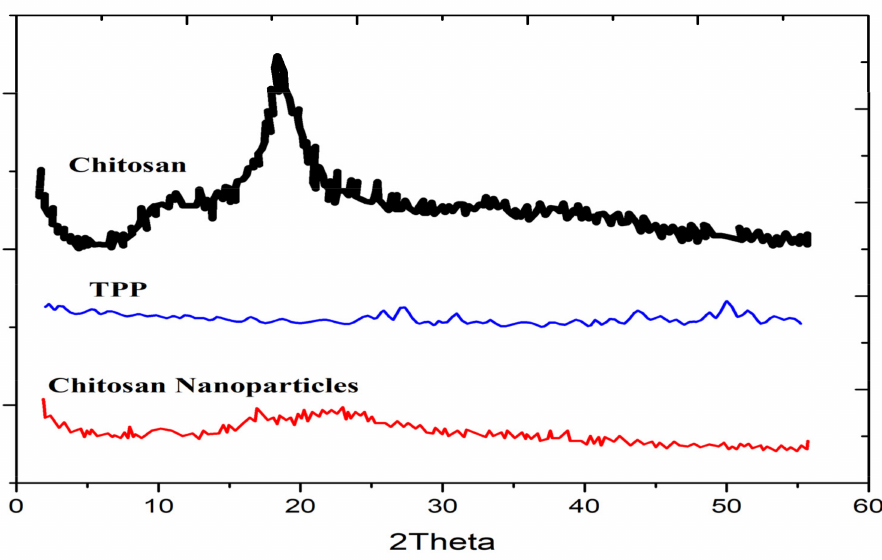
Figure 2. XRD patterns of pure chitosan, TPP, and chitosan nanoparticles reproduced from Ali et al.